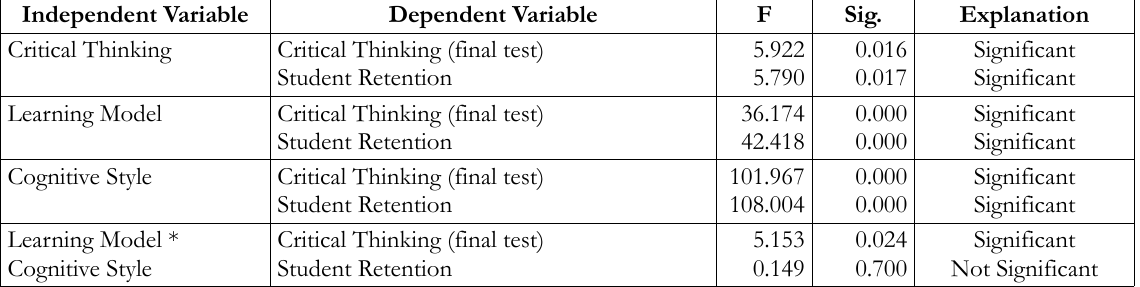
Table 12. Tests of Between-Subjects Effects Multivariate of Covariance